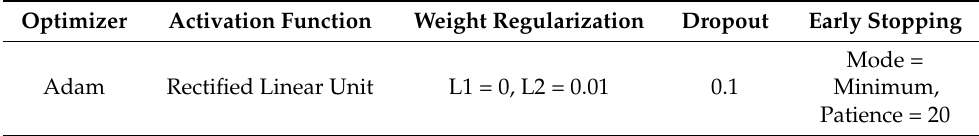
Table 5. BiLSTM model variables and hyperparameters obtained from grid